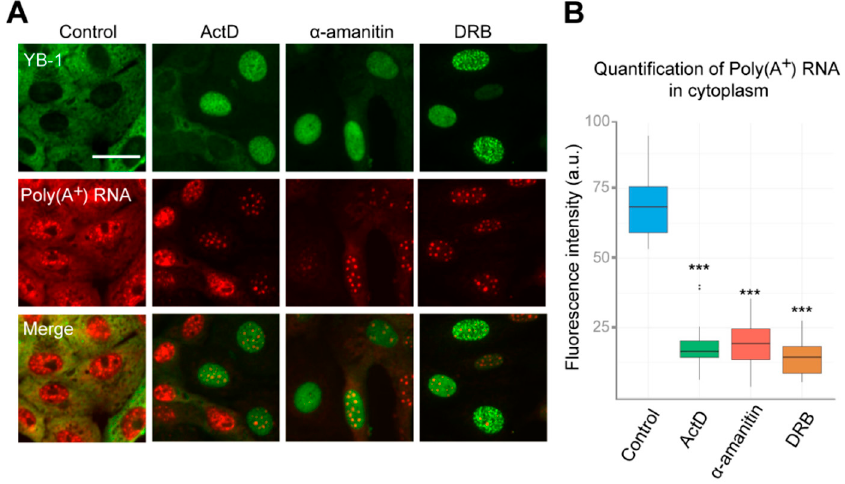
Figure 2. Inhibition of RNAPII affects distribution of poly(A + )RNA in the cell. ( A ) Intracellular localization of YB-1 and poly(A + ) after in situ hybridization in Vero cells exposed to DMSO (control), DRB, ActD, and α -amanitin for 24 h. Scale bar 50 µ m. ( B ) Quantification of cytoplasmic poly(A + )RNA levels in control cells or exposed to the inhibitors of transcription. Results are mean ± SD. *** p < 0.001, paired t -test; n = 25 for each condition in three independent experiments.